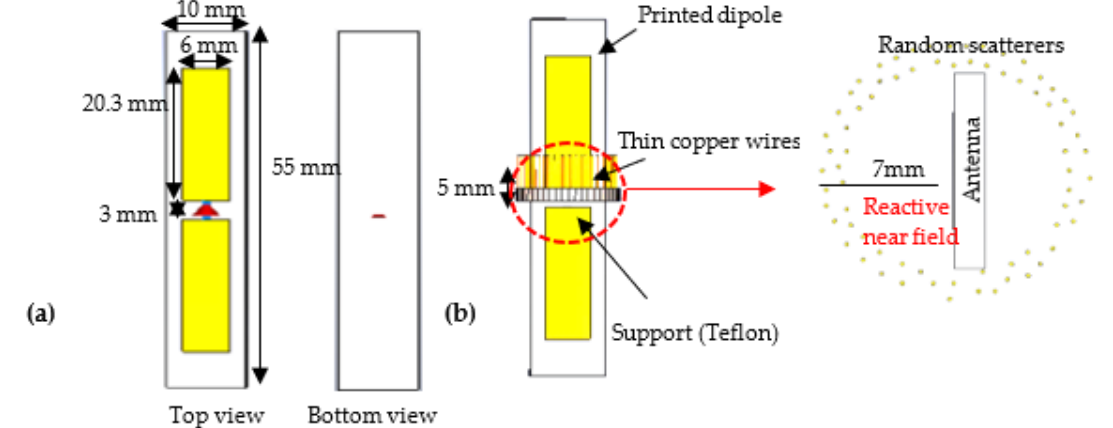
Figure 4. ( a ) Printed dipole antenna without scatterers, ( b ) printed dipole with scatterers.